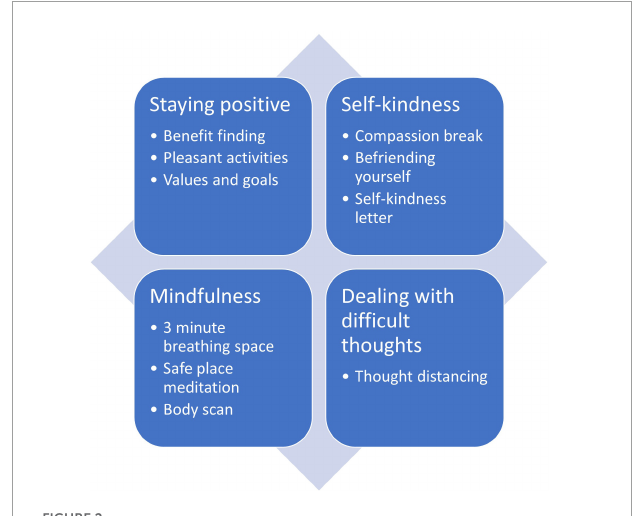
FIGURE2 Self-guided emotion regulation strategies used in the